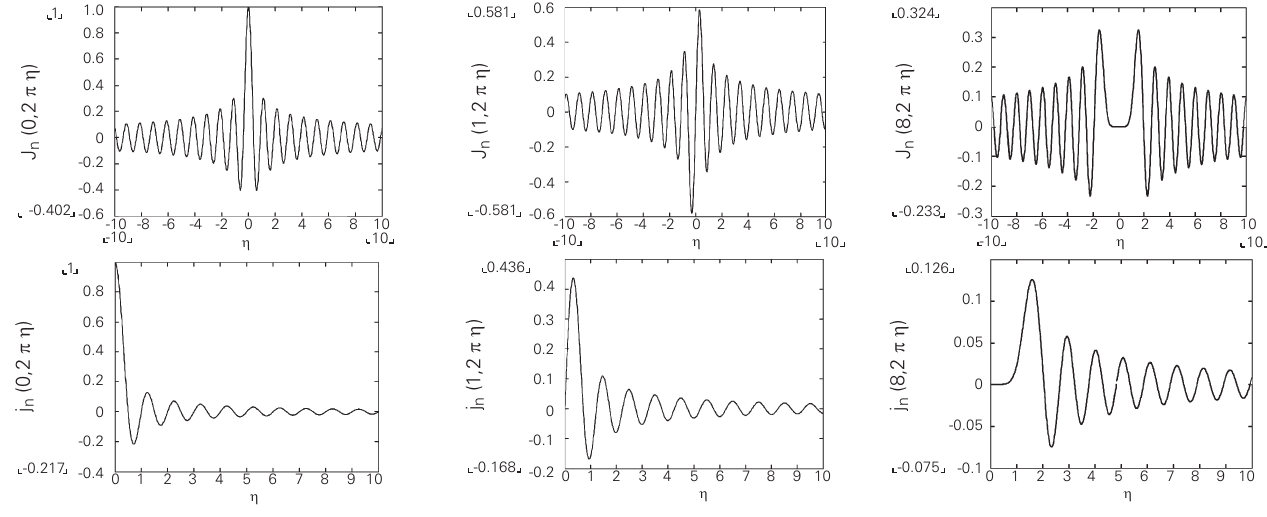
Figure 1. Profiles of cylindrical Bessel functions, J n (top), and spherical Bessel functions, j n (bottom), for n = 0 (left), n = 1 (center) and n = 8 (right). Profiles of j n (bottom) are defined only for n from 0 (zero) to